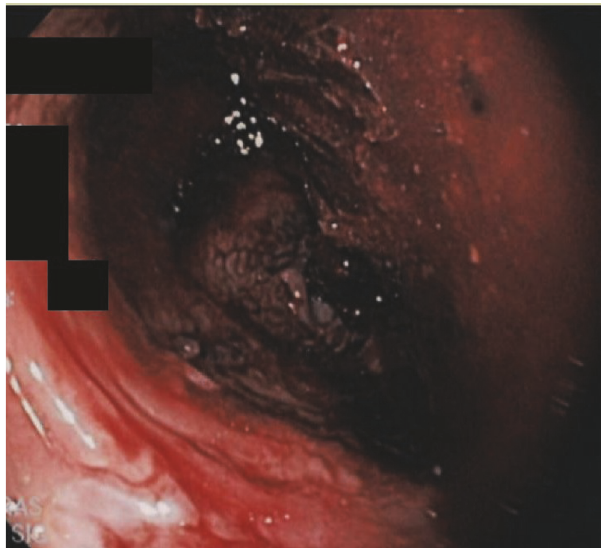
Figure 1: Flexible sigmoidoscopy showing a circumferential rectal ulcer with erythematous mucosa.